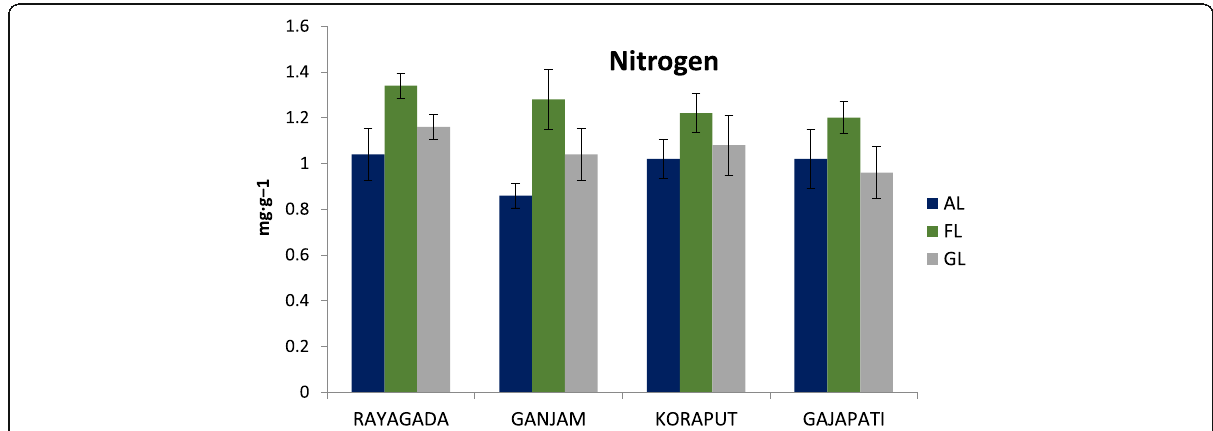
Fig. 3 Total nitrogen percentage with means under different habitat conditions across four